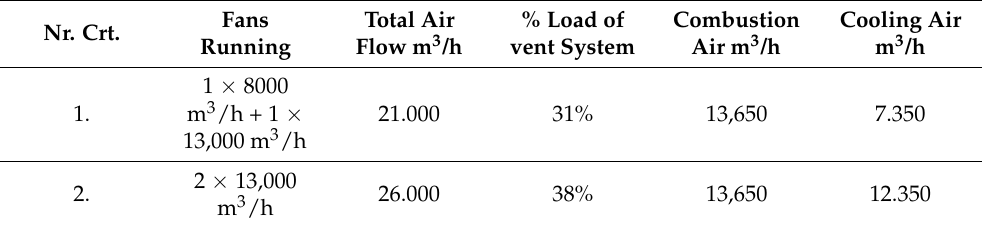
Table 7. The air flow, fans running, and load of the ventilation system in two alternatives analyzed for adiabatic